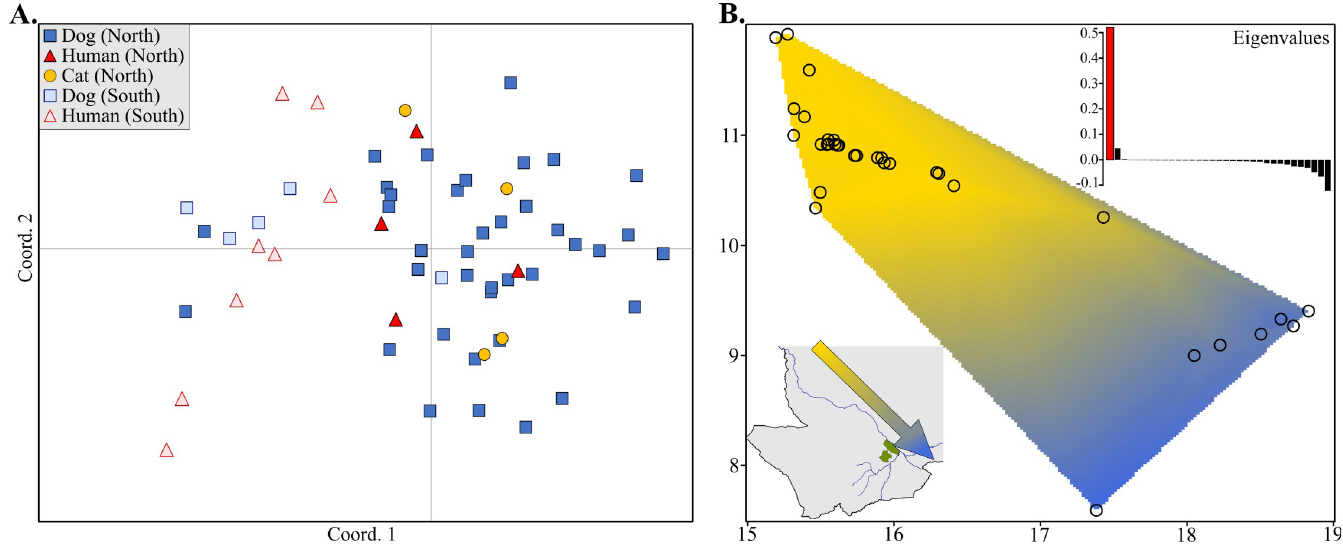
Fig 4. PCoA and sPCA suggest geographic differentiation of Chadian D . medinensis but no differentiation by host species. (A) PCoA of derived maternal genotypes for Chadian parasites. Point shape and color denote host species, and fill transparency indicates broad geographic origin of the parasite (northern or southern region). (B) Interpolation of lagged principal scores of the first component from the sPCA, plotted over the sampling area in Chad. Sampling locations of each parasite specimen are indicated by open circles, and genetic similarity is represented by color contours. The arrow in the lower left inset illustrates the clinal gradient in the context of the dominant geographic features of the sampling area. A barplot of the eigenvalues produced by the sPCA is shown in the upper right insert, illustrating the dominance of the first component within the sPCA.